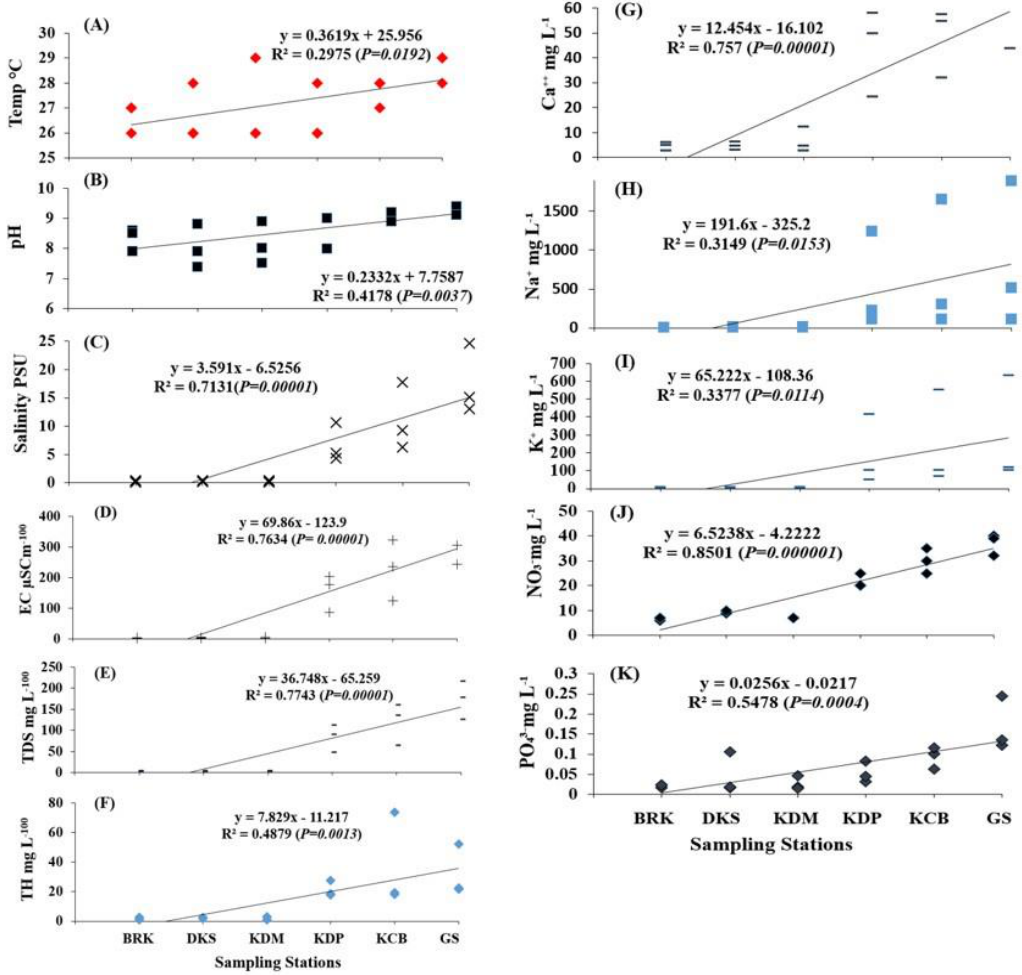
Figure 2. Seaward trends of selected physical parameters estimated for the present study at six sampling sites (Table 1) during October 2017, February 2018, and June 2018, including ( A ) temper- ature, ( B ) pH, ( C ) salinity, ( D ) electrical conductivity, ( E ) total dissolved solids, ( F ) total hardness, ( G ) calcium, ( H ) sodium, ( I ) potassium, ( J ) nitrate, and ( K )